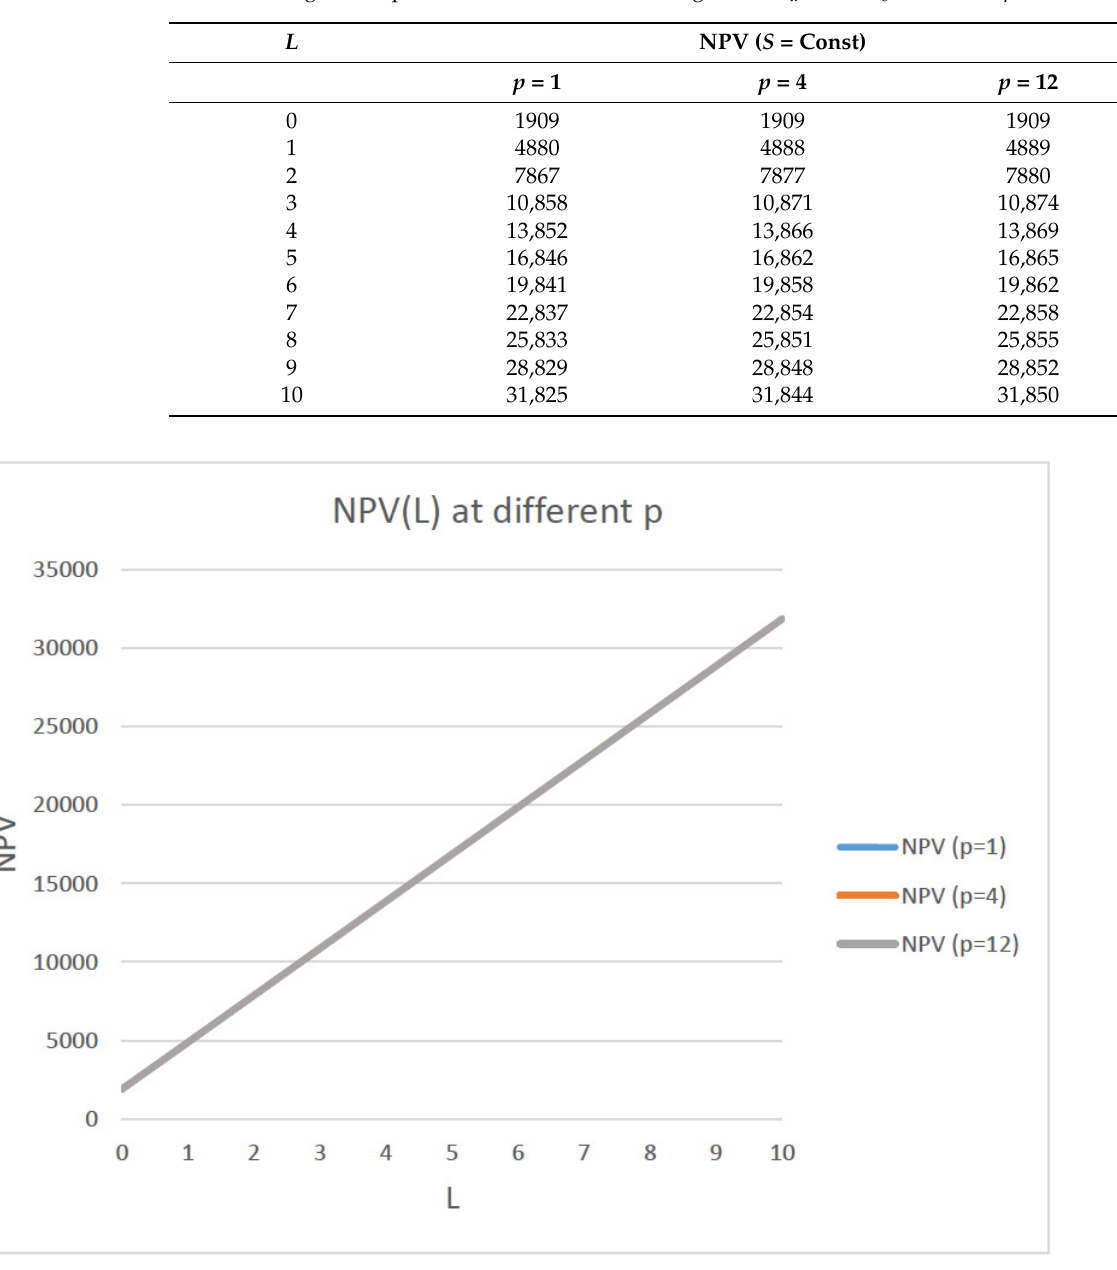
Figure 6. Change of net present value, NPV, with leverage, L , for k d = 0.14, k 0 = 0.22, and p = 1, 4, and 12, for a perpetuity project.